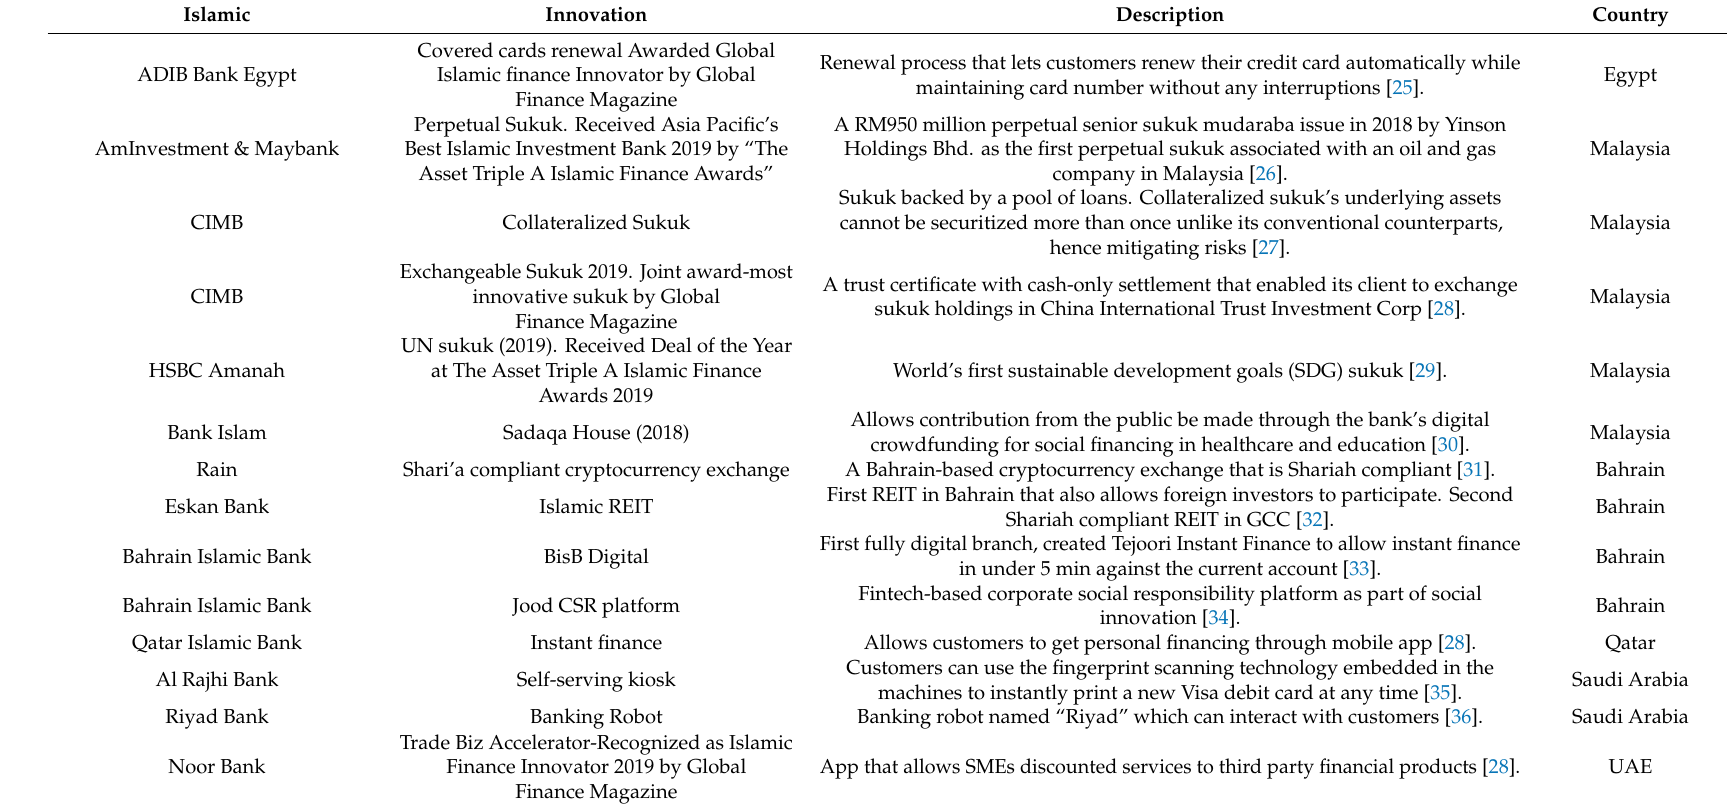
Table 2. Financial Innovation Comparison: Islamic Finance vs. Conventional Finance